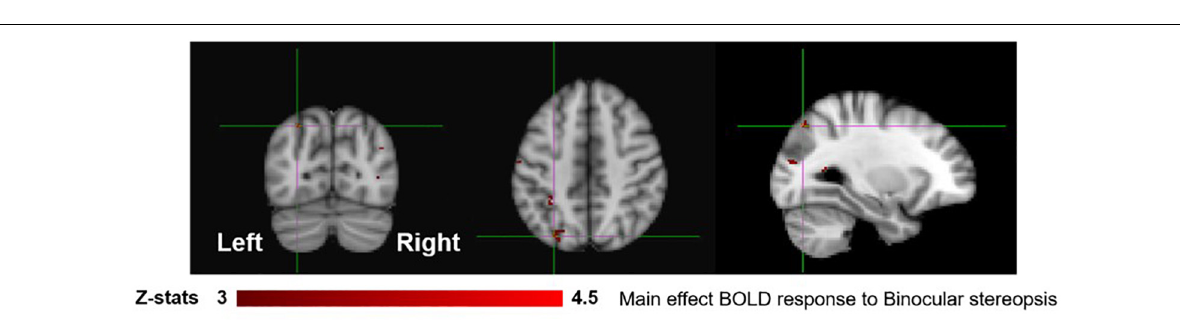
FIGURE 6 | Group results for binocular stereopsis, revealed by the fixed-effects ( N = 7) GLM contrast [SA DISP > SA NO − DISP ]. All responses are masked to gray matter. Uncorrected p < 0.001. The crosshairs represent the peak in the left parietal cortex [MNI coordinates: − 28, − 74, and 46].